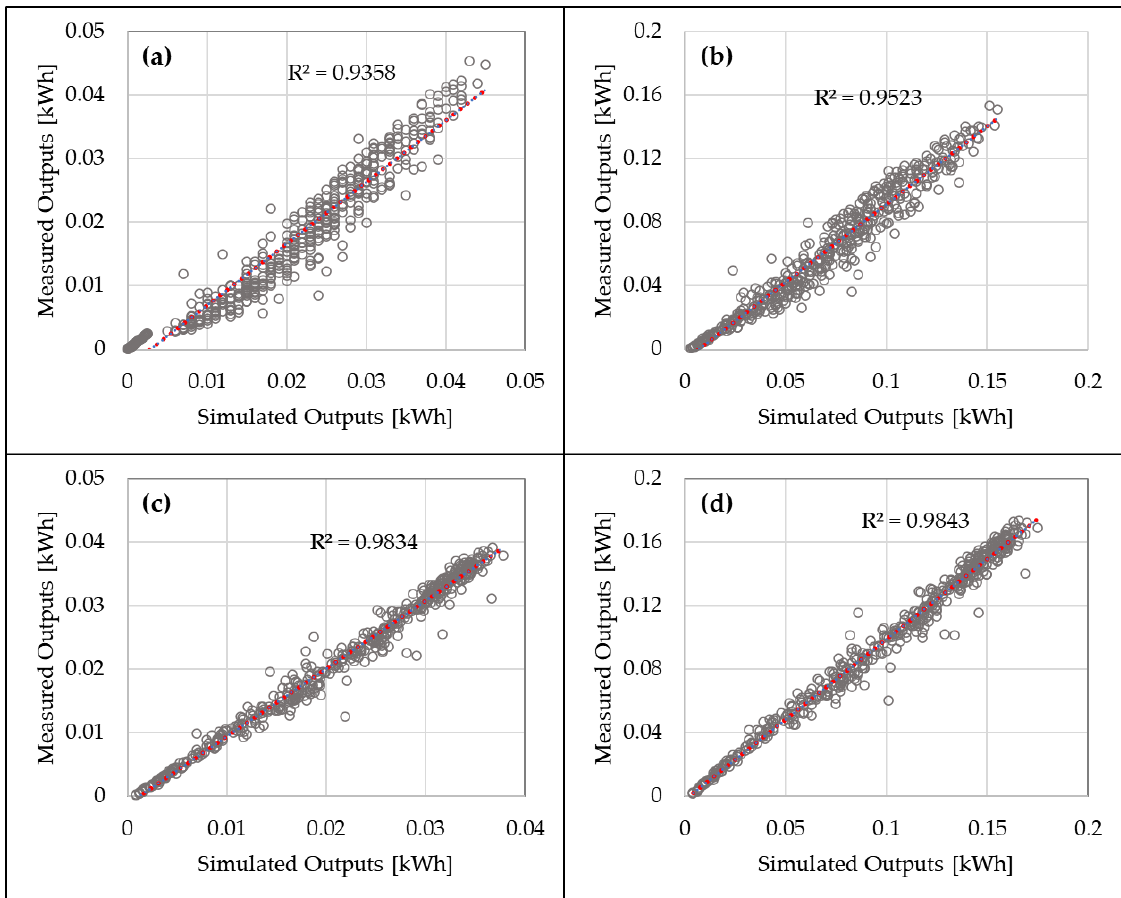
Figure 12. Measured versus simulated data during the comparative period (three months) for ( a ) cracked-vertical, ( b ) reference-vertical, ( c ) cracked-inclined, and ( d ) reference-inclined modules. Table 3. CVRMSE comparison between measured and simulated data.